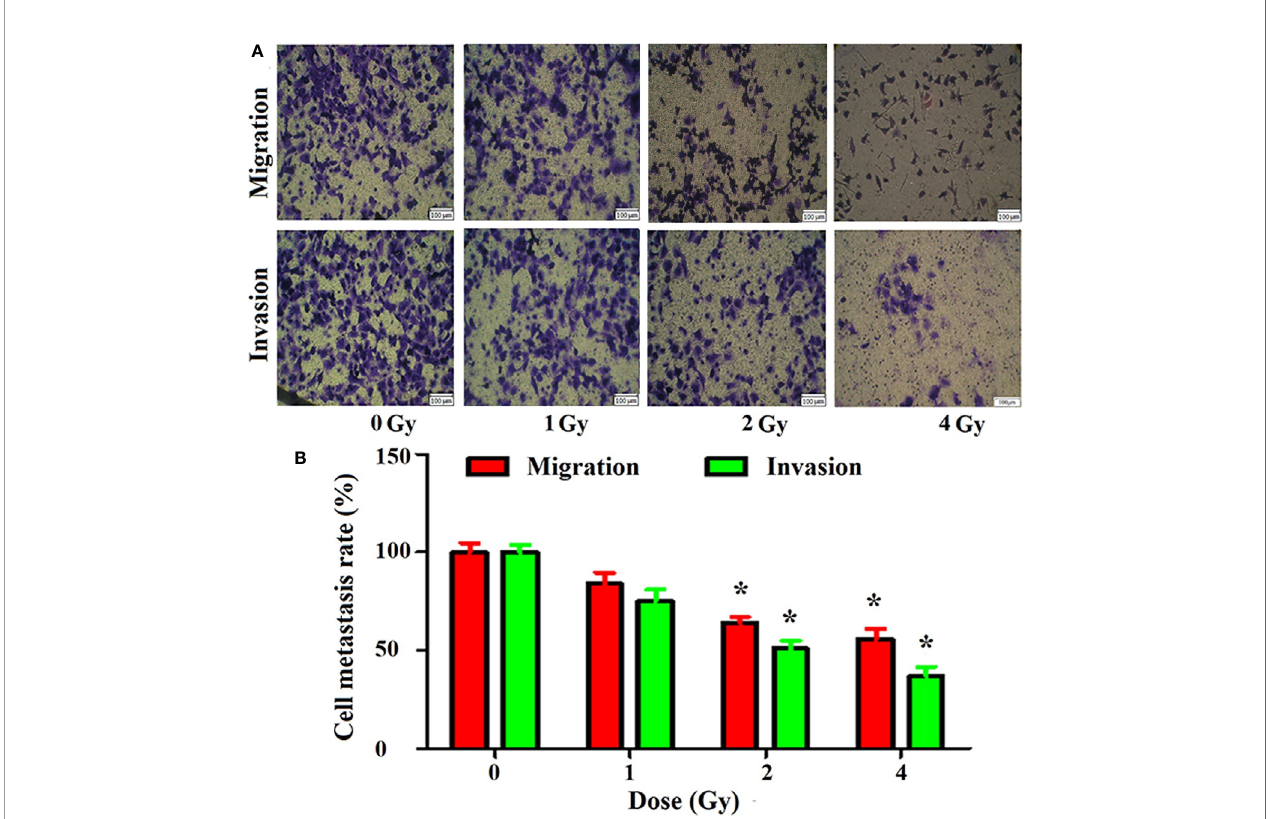
FIGURE 2 | Inhibition of migration and invasion of A549 cells by carbon ions [ (A) migration and invasive staining, (B) metastasis difference analysis] *p <